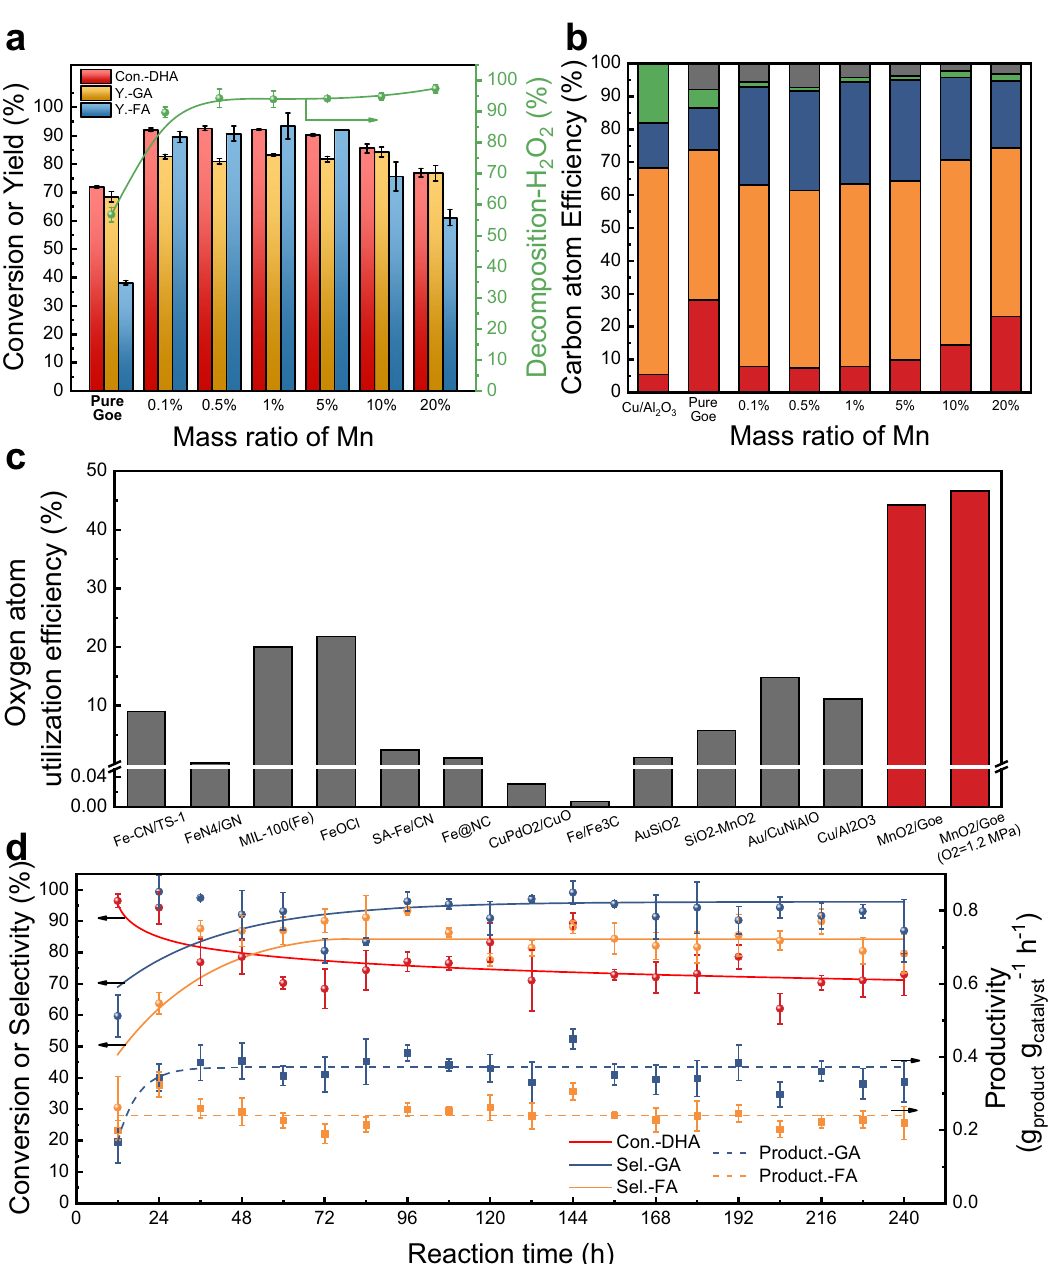
Fig. 3 Catalytic activity, atom ef fi ciency, and continuous stability test. a, b Catalytic activity and carbon atom ef fi ciency for DHA oxidation over MnO 2 / Goe with different mass ratio of Mn. Red: unreacted DHA; Orange: GA; Blue: FA; Green: CO 2 ; Gray: unknown intermediates. c Comparison of oxygen atom utilization ef fi ciency for the typical heterogeneous catalytic oxidation processes using H 2 O 2 as oxidant. The detailed information of these systems was listed in Supplementary Table 2. d Catalytic performance of the MnO 2 /Goe catalyst under the continuous fl ow condition. Reaction conditions for DHA oxidation: catalyst 30 μ mol, DHA 1 mmol, H 2 O 2 0.2 mL (30 wt% H 2 O 2 aqueous), 25 °C, 400 rpm, 24 h (batch experiment); catalyst 2 g, 1 mmol DHA in